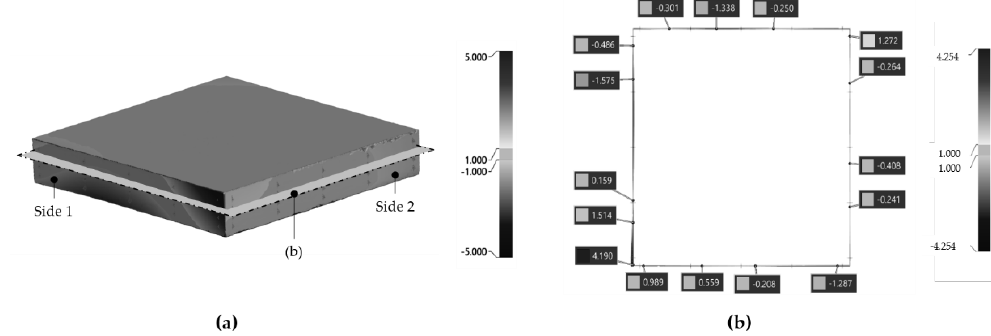
Figure 16. Analysis method of FCP shape errors: ( a ) Scan data; ( b ) Cross section of scan data.